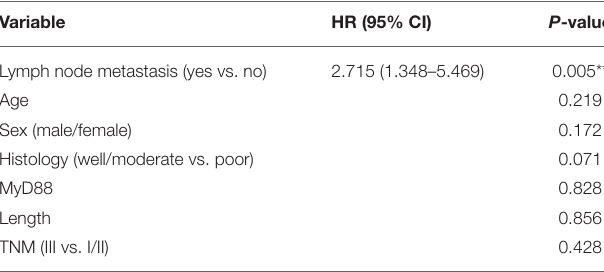
TABLE 4 | Multivariate analysis of factors associated with survival in GCC patients.